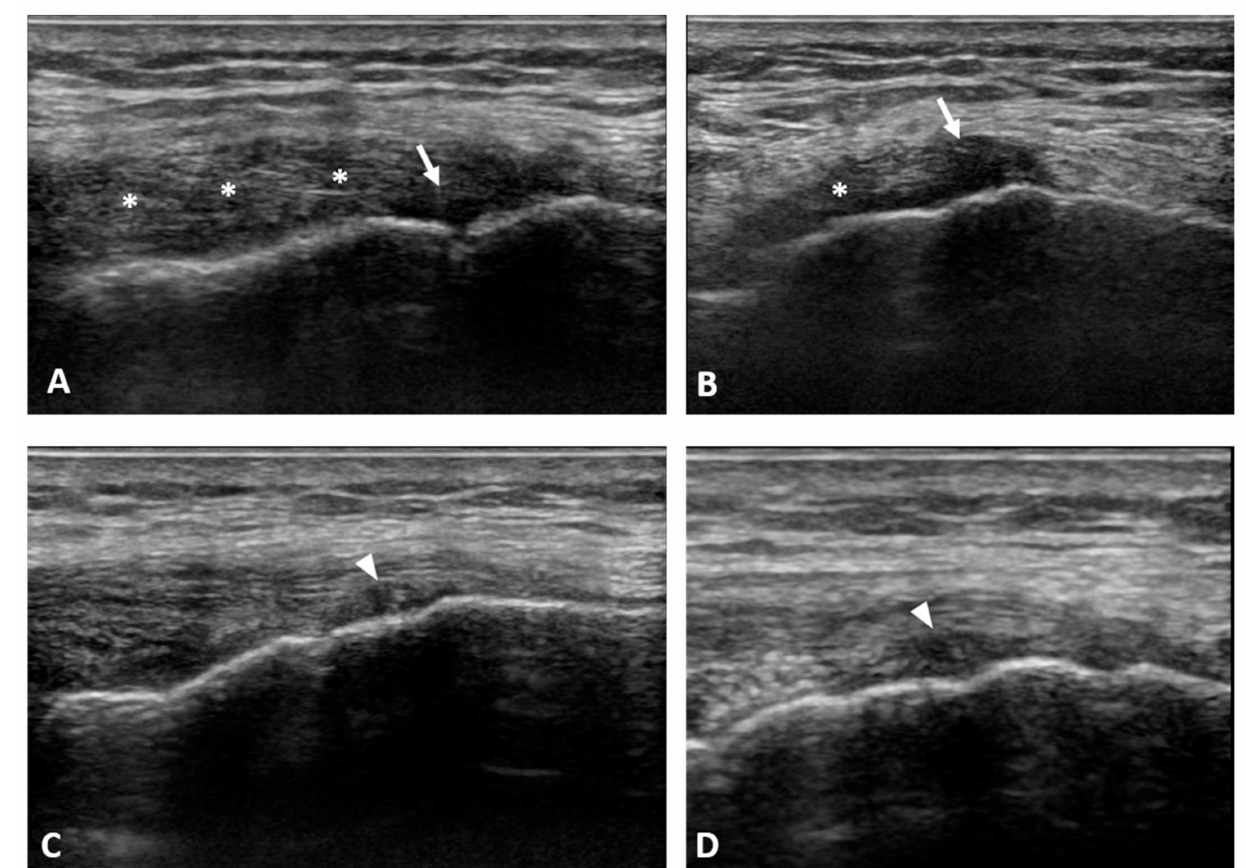
Figure 1. The pre-treatment ultrasound (US) examination at the painful area revealed a thickened and hypoechoic MCL ligament at its proximal (femoral) insertion (asterisks) with a focal area of the lesion (arrows) at the deep fibers ( A , B ). At 1-month follow-up the US examination showed an initial deposition of “newly formed tissue” at the site of previous injury of the proximal MCL insertion (arrowheads), with an initial reduction in MCL thickness ( C , D